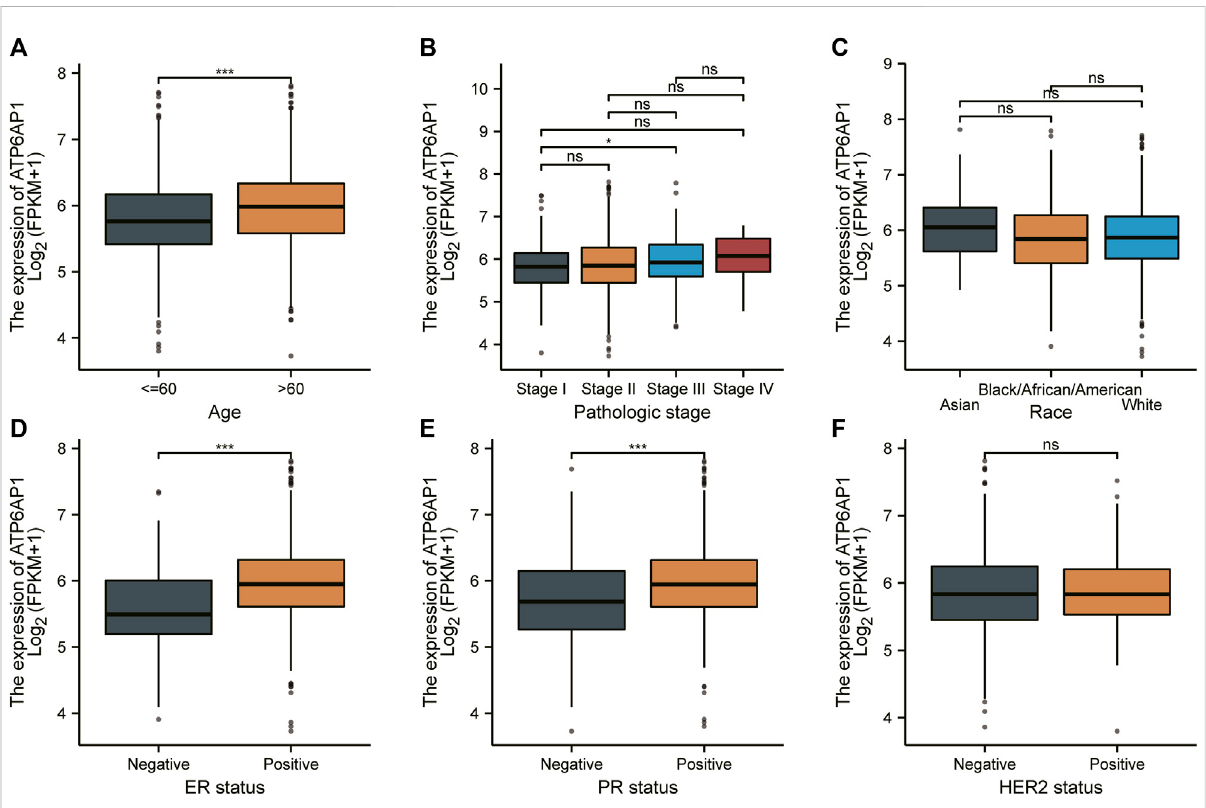
FIGURE 8 RelationshipbetweenATP6AP1expressionandclinicopathologiccharacteristicsinpatientswithbreastcancer. (A) Age. (B) Pathologicstage. (C) Race. (D) ER status. (E) PR status. (F) HER2 status. ns, non-signi fi cant ( p ≥ 0.05); * p < 0.05; ** p < 0.01; *** p <